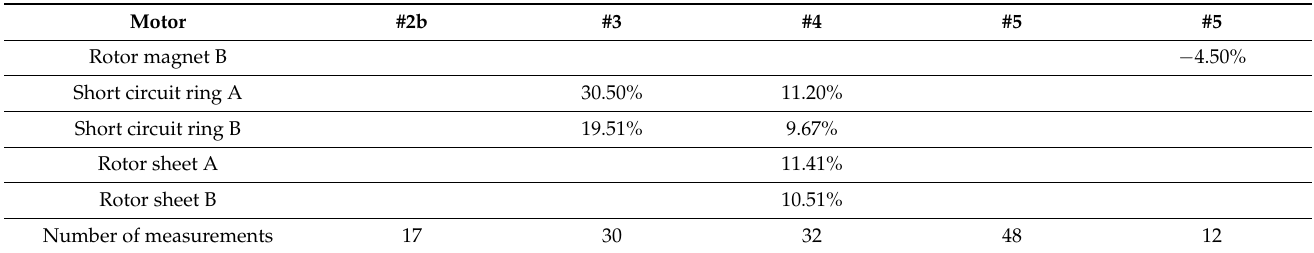
Figure 8. Drive cycle simulation vs. measurement of motor #2 and #3. The results of the dynamic drive cycles show that the model can predict the thermal drive cycle behavior in a quite good accuracy, even when there are still relative errors in